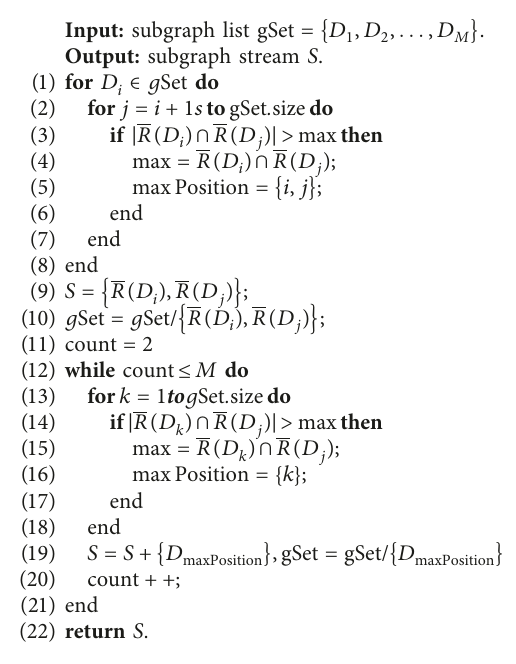
A LGORITHM 3: Constructing the subgraph stream algorithm based on the overlap degree of approximations in rough sets named